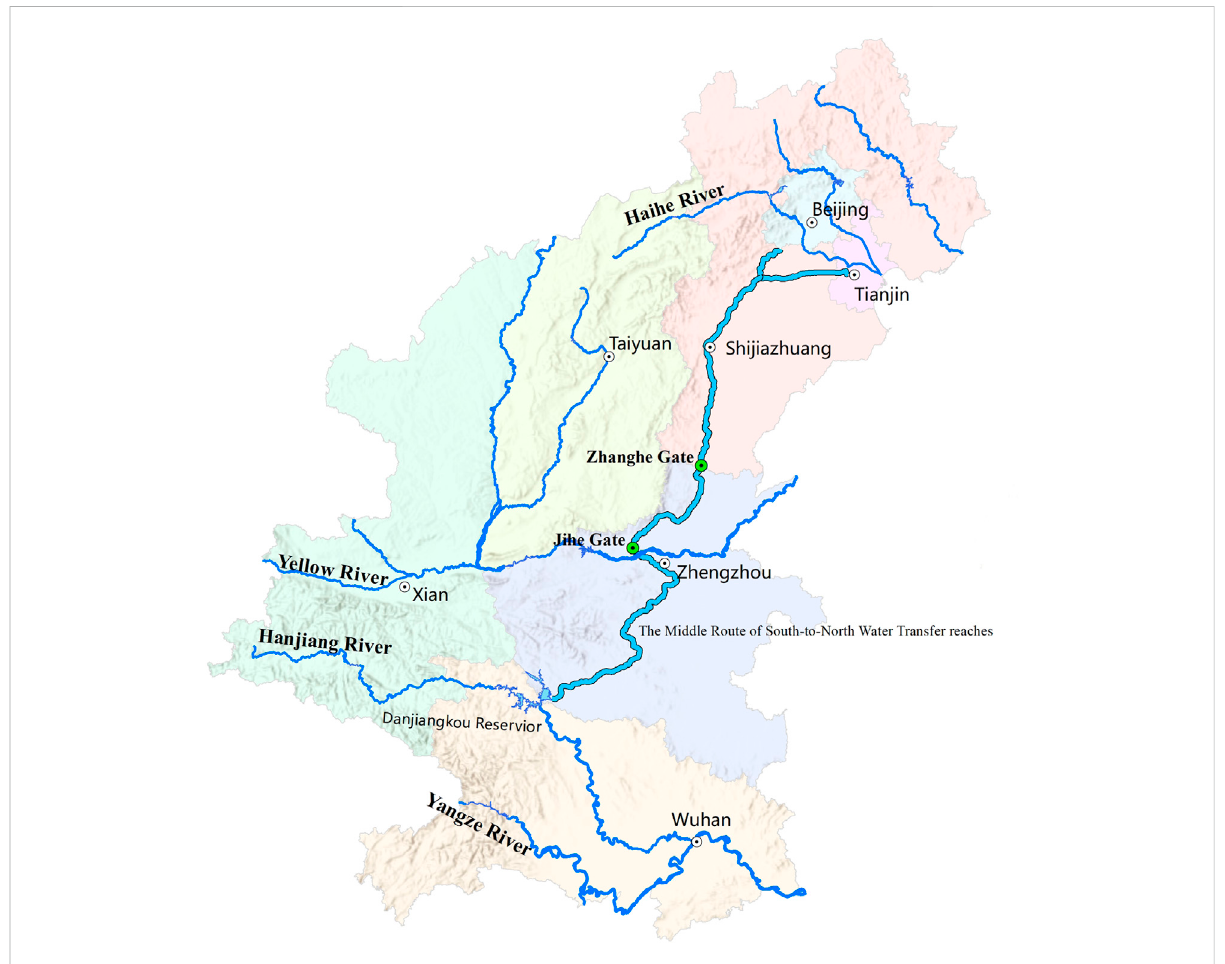
FIGURE 7 The middle route of South-North Water Diversion